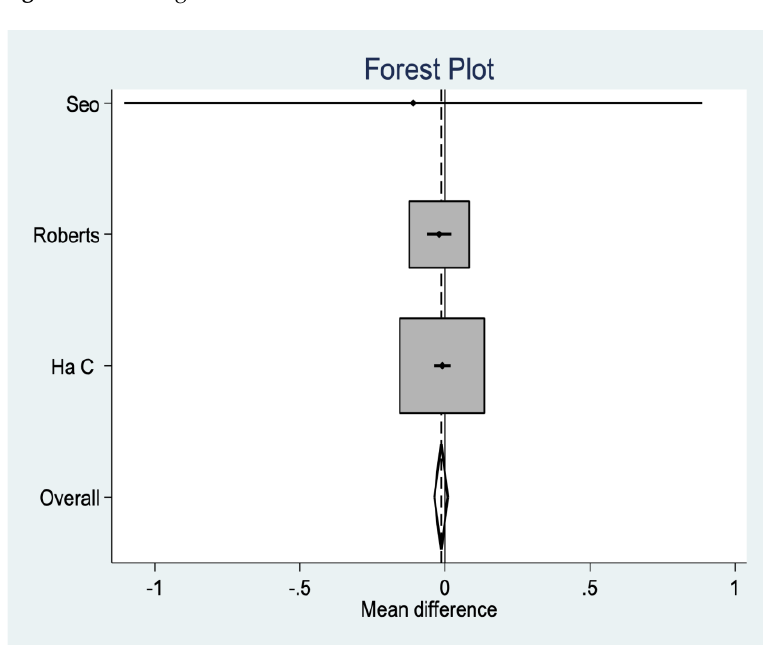
Figure 9. Radiological variable data.